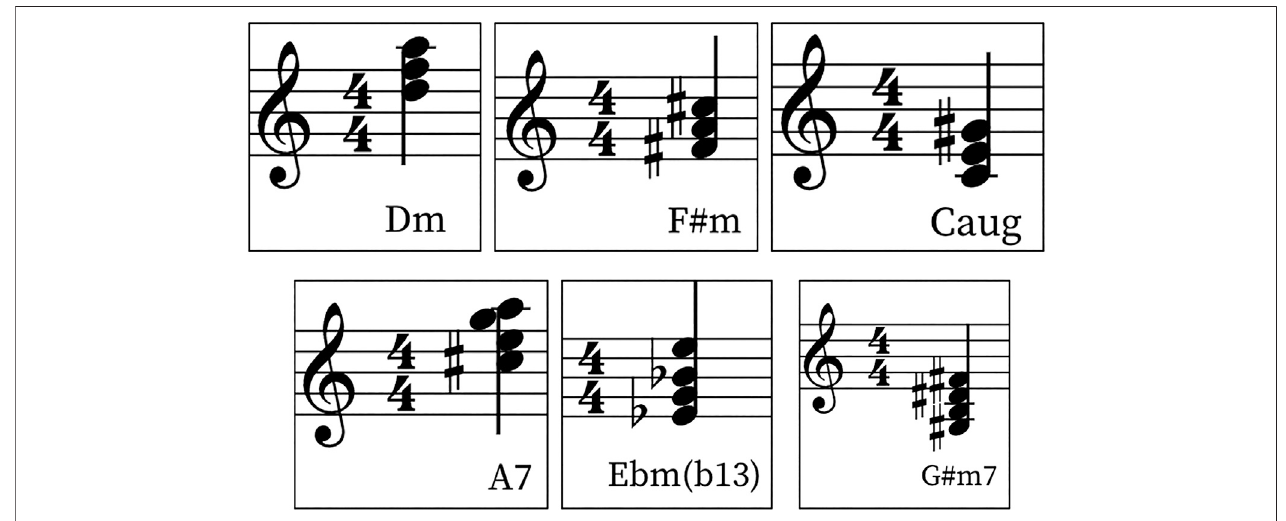
FIGURE 6 | New chords generated by the TimbreNet model. The top three chords are new but they are similar to chords that can be found in the training set. The bottom threechordsarecompletelynovel, withdifferentnumber ofnotesand representing differenttonalfunctions,suchasadominantseventhorminor-minorseventh chords..